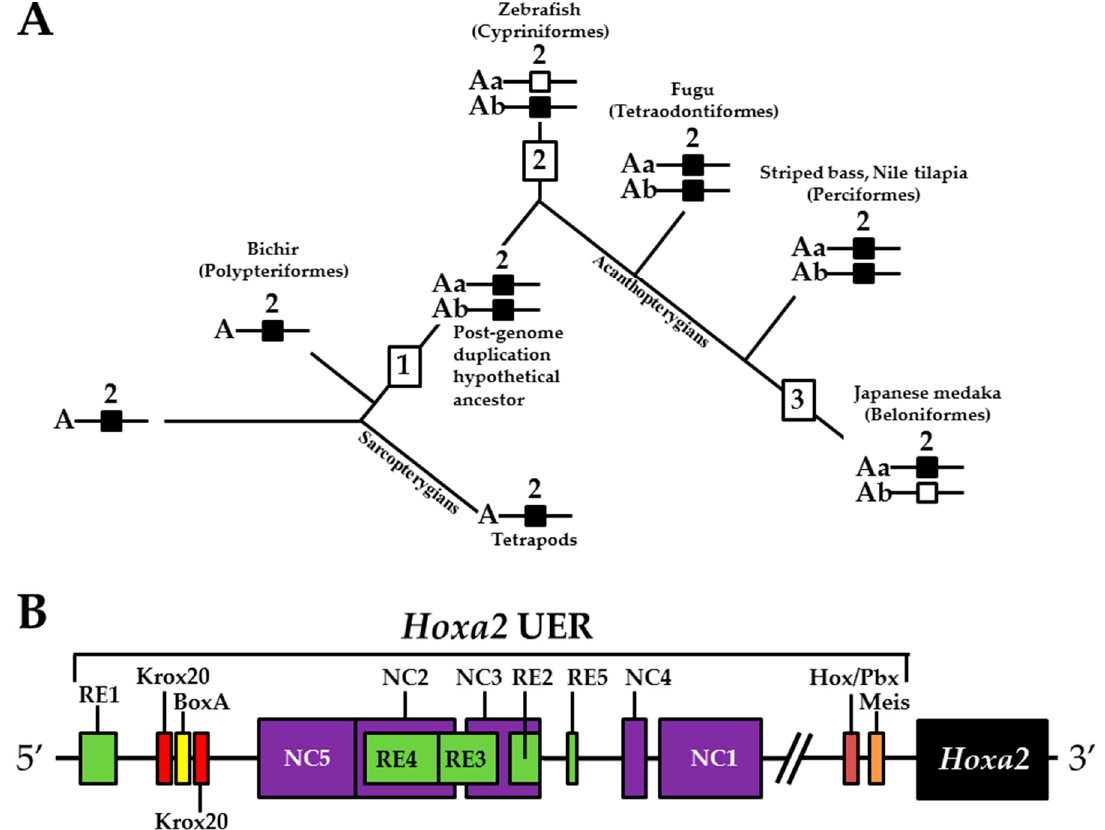
Figure 1. Evolution of Hoxa2 gene complement and Hoxa2 UER composition. ( A ) Phylogeny based on Steinke et al. (2006) [58]: (1) Genome duplication; (2) hoxa2a gene loss; and (3) hoxa2b gene loss. Filled in boxes represent functional Hoxa2 genes. Open boxes represent loss of Hoxa2 gene function. ( B ) Genomic map of the Hoxa2 UER characterized in mouse. The genomic map was not drawn to scale. RE, rhombomeric element; NC, neural crest.